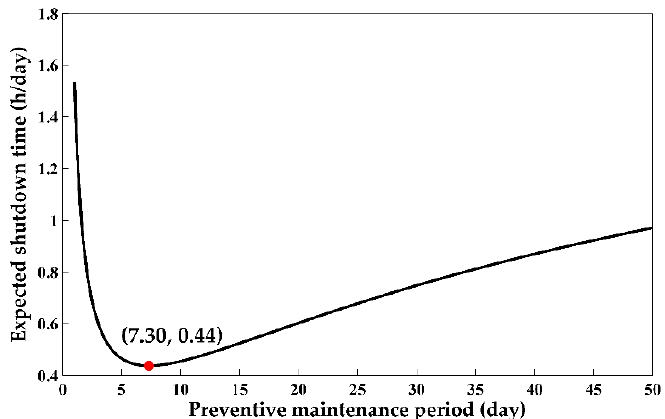
Figure 4. The relationship between expected shutdown time of the production line and the preventive maintenance period.